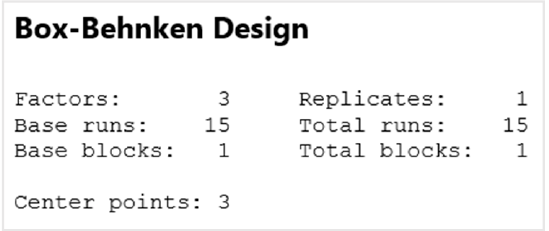
Figure 15. Box–Behnken design running setup. Table 6. Box–Behnken design (three continuous factors).